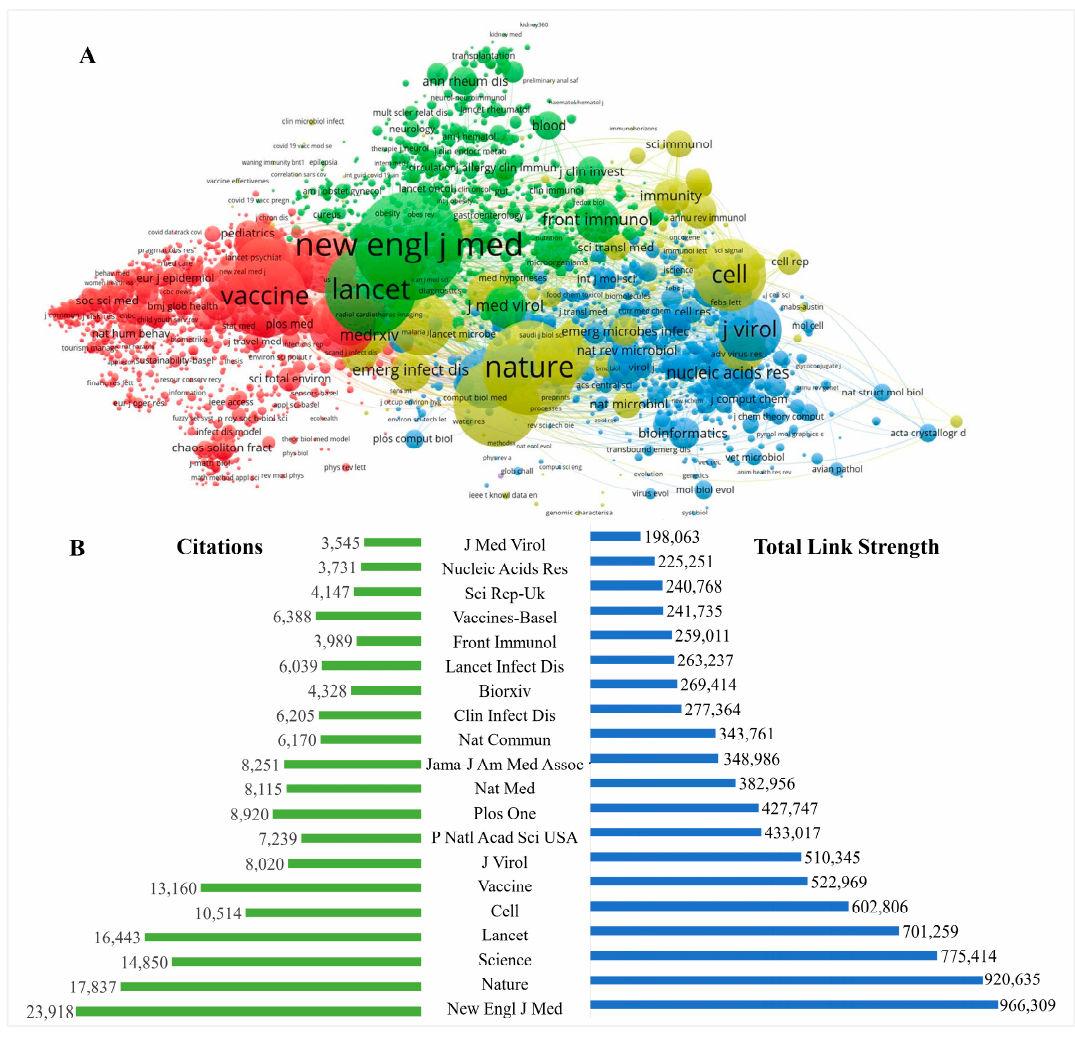
Figure 5. The top 20 active journals and co-citation cited sources visualization map within COVID-19 vaccine research, by VOSviewer analysis. ( A ) network visualization map of top 2980 cited sources (co-citations more than 22); ( B ) the top 20 highest TLS journals. The size of the nodes represents the citation frequency of journals, and journals with the same color in the view belong to the same clusters in the cooperation